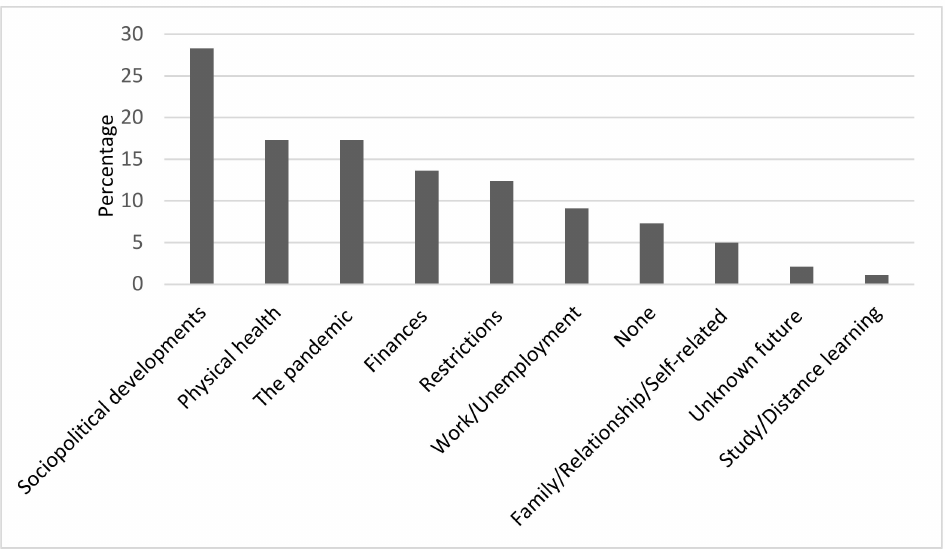
Figure 3. Sources of greatest concern for the future. The percentages of participants reporting each main category of concern that emerged from the data for the third question: “What is your biggest worry when you think about the